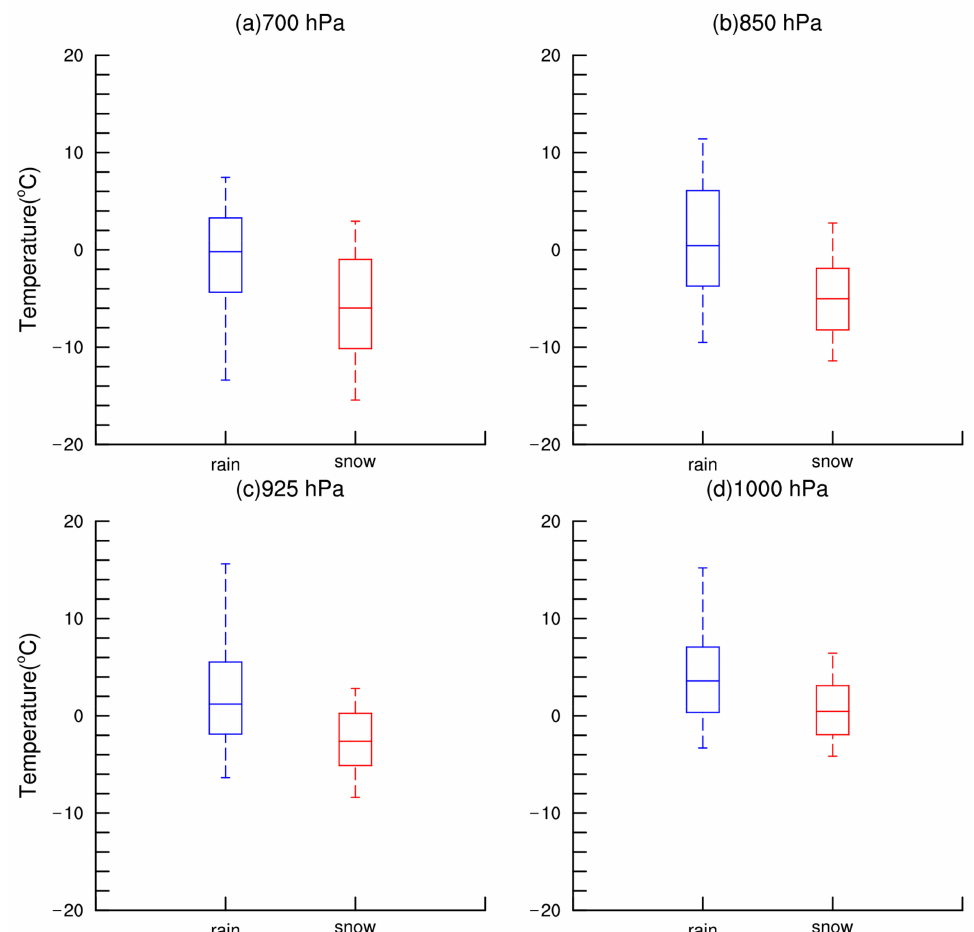
Figure 9. Box-whisker plot of the perfect and good flagged GIIRS temperature for different precipita- tion types. The upper and lower boundaries of the box indicate the 90 and 10 percentiles. The median is represented by the horizontal line inside the box. The maximum and minimum temperature values are indicated by the top and bottom ends of the whiskers, respectively. ( a ) 700 hPa; ( b ) 850 hPa; ( c ) 925 hPa; ( d ) 1000